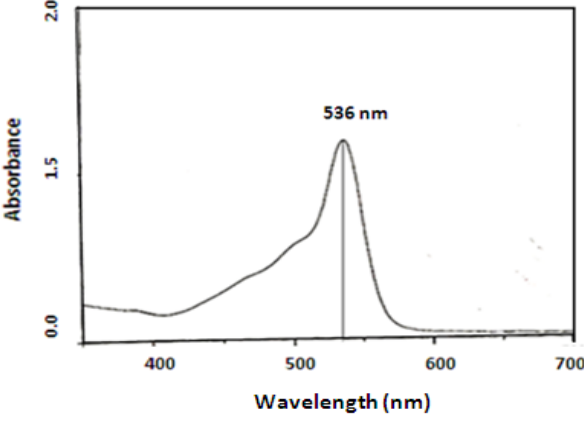
Figure 4. Absorbance spectrum of prodigiosin purified by Serratia marcescens UCP 1549.